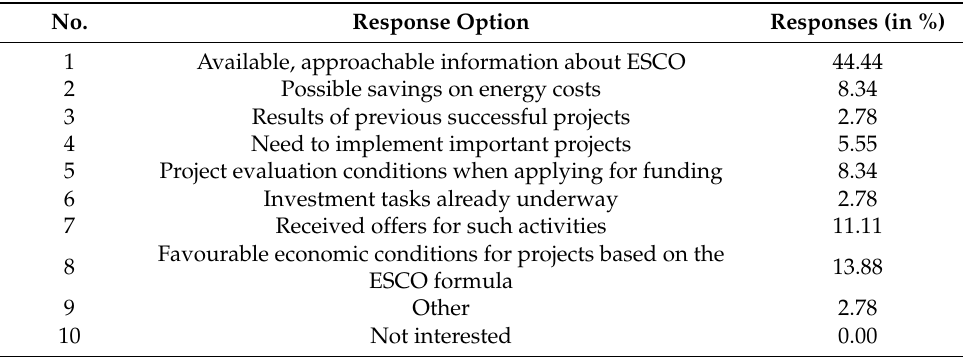
Table 2. Reasons for interest in the ESCO formula. Source: CAWI